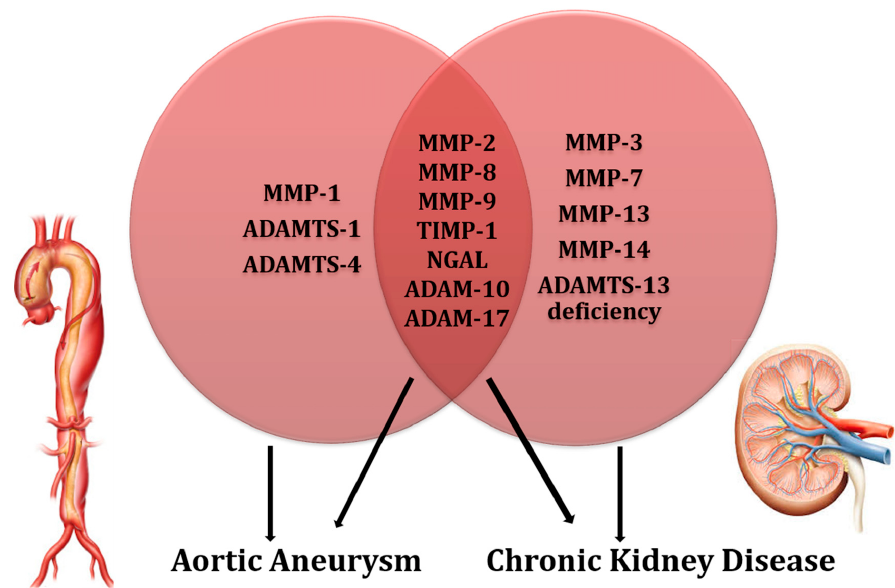
Figure 1. Metalloproteinases (MPs) in the pathogenesis of CKD and AA. The two circles contain the MPs associated with each clinical condition (indicated with the arrow), whereas the intersection area (darker colored) shows the MPs associated with both conditions.